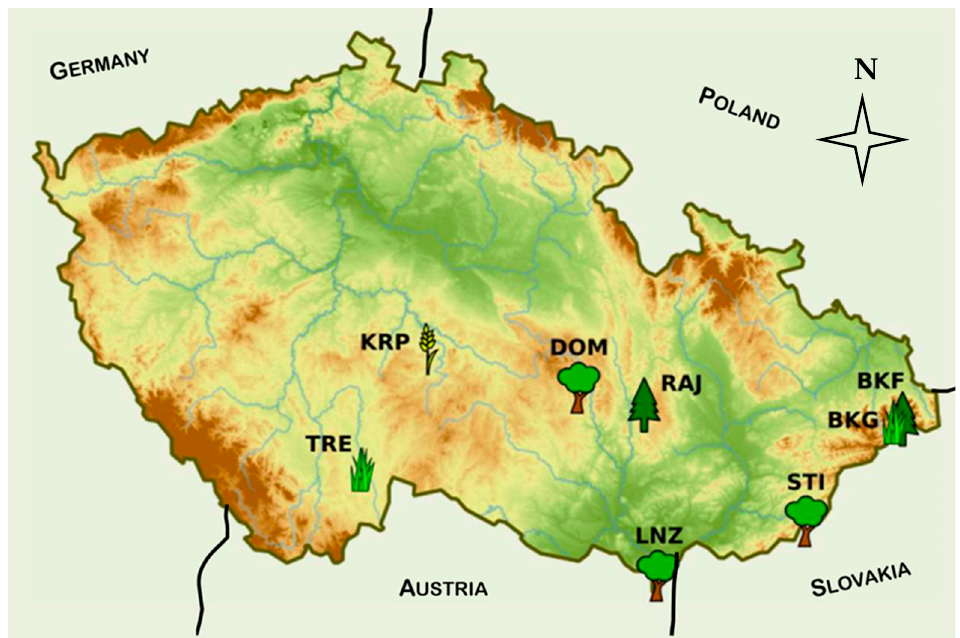
Figure 2. CzechGlobe sites (CzeCOS network). BKF: Bily Kriz spruce forest, BKG: Bily Kriz grassland, STI: Stitna beech forest, RAJ: Rajec Jestrebi spruce forest, LNZ: Lanzhot floodplain forest, DOM: Domaninek poplar plantation, KRP: Kresin agroecosystem, and TRE: Trebon wetland.